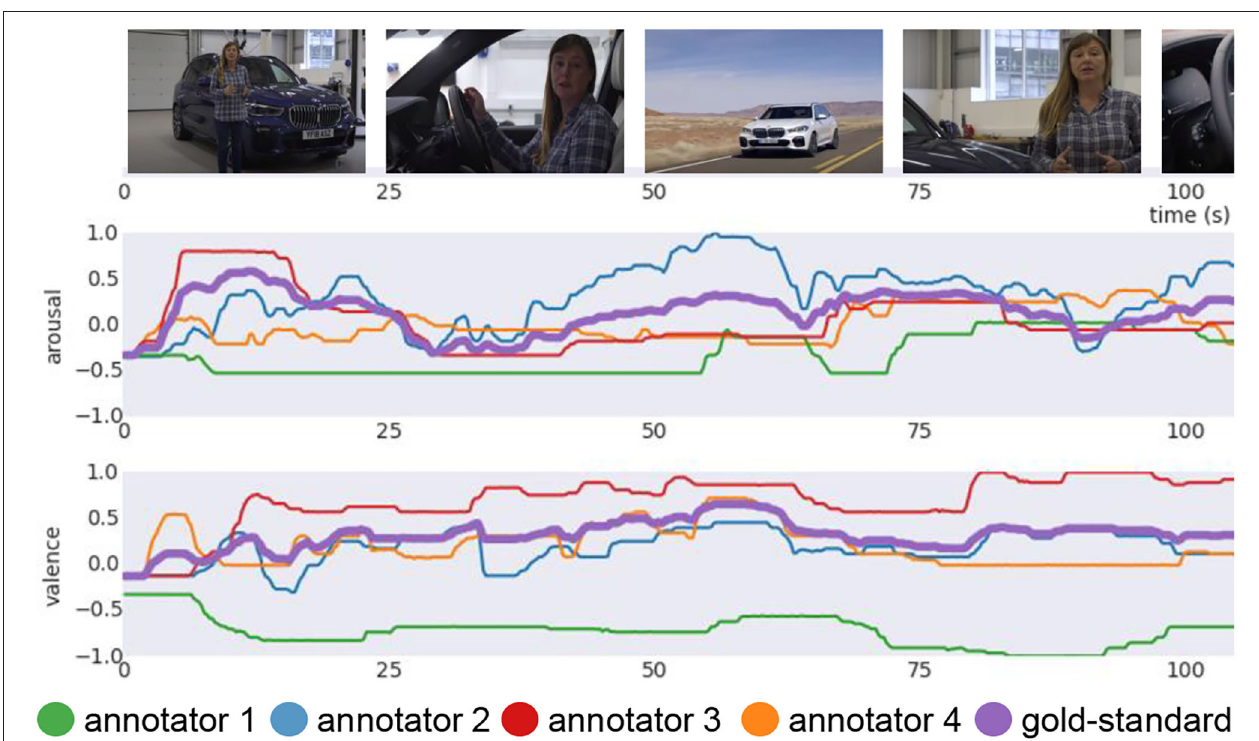
FIGURE 1 | Example video (video ID 5): Four annotation signals for arousal and valence in addition to the fused EWE “gold-standard” signal (bold purple). The annotator 1 (green) has a negative correlation to the others on valence. The weight ( r 1 ) is set to 0, not considered for the fused gold-standard by EWE.